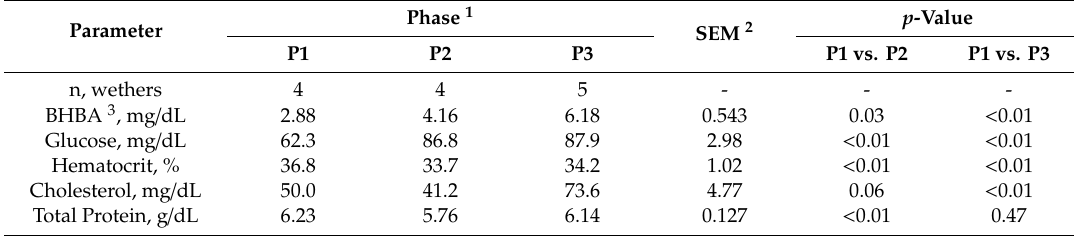
Table 5. Impacts of time-fed concentrate-based diets on plasma metabolites of wethers.